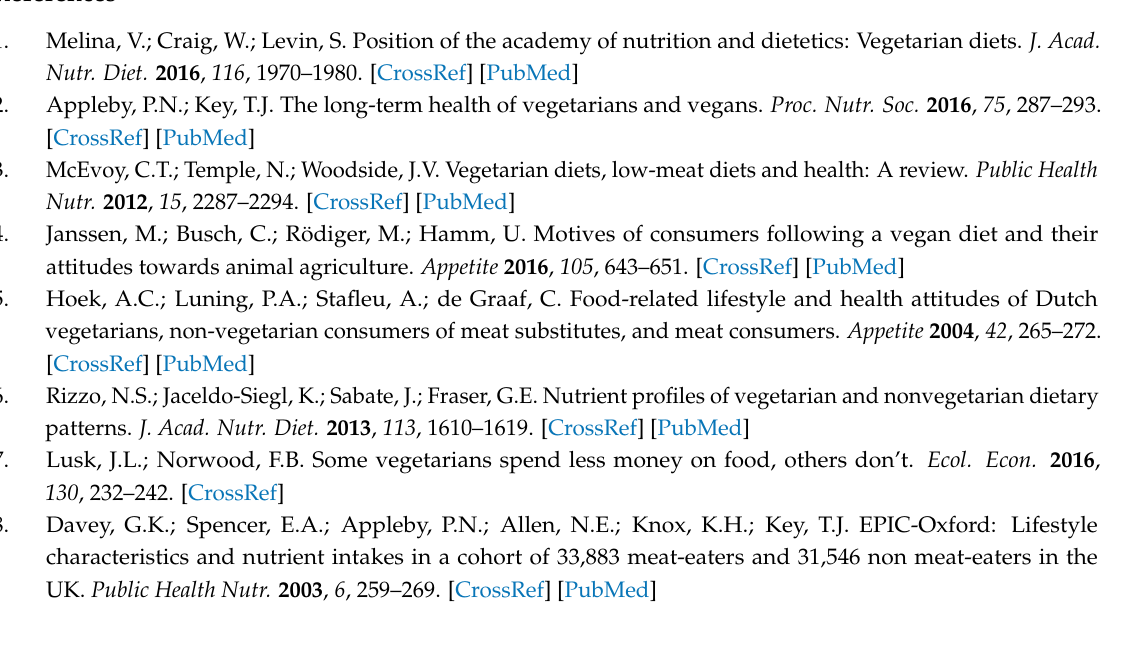
Table S1: Mean nutrient intake by age and sex groups among vegetarians, vegans and meat eaters (Nutrinet-Sant é Study 2009–2015, n =